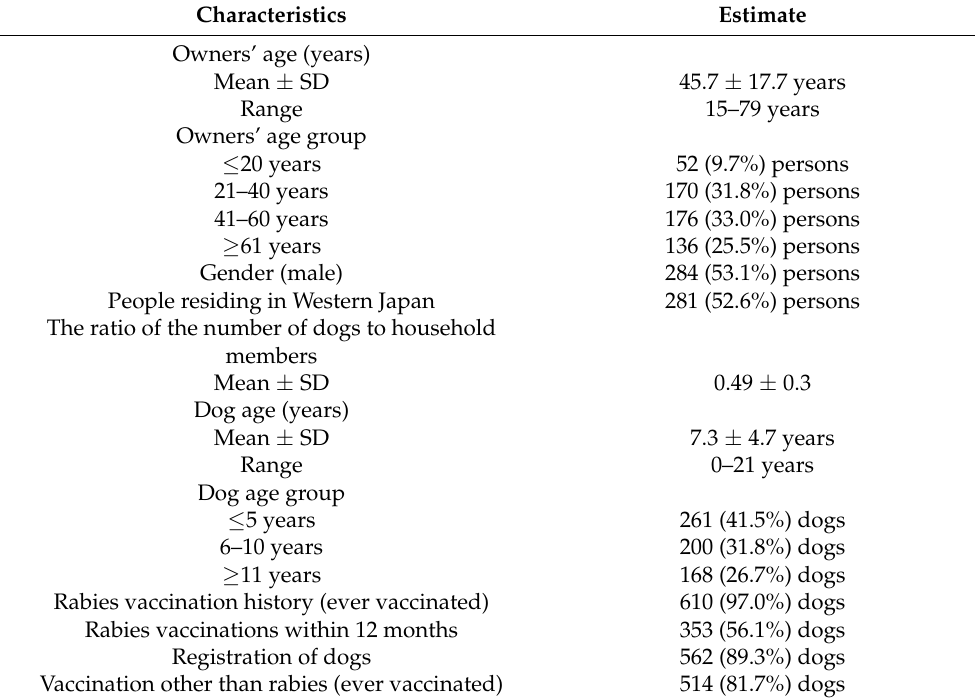
Table 1. Characteristics of owners ( n = 534) and dogs ( n = 629),